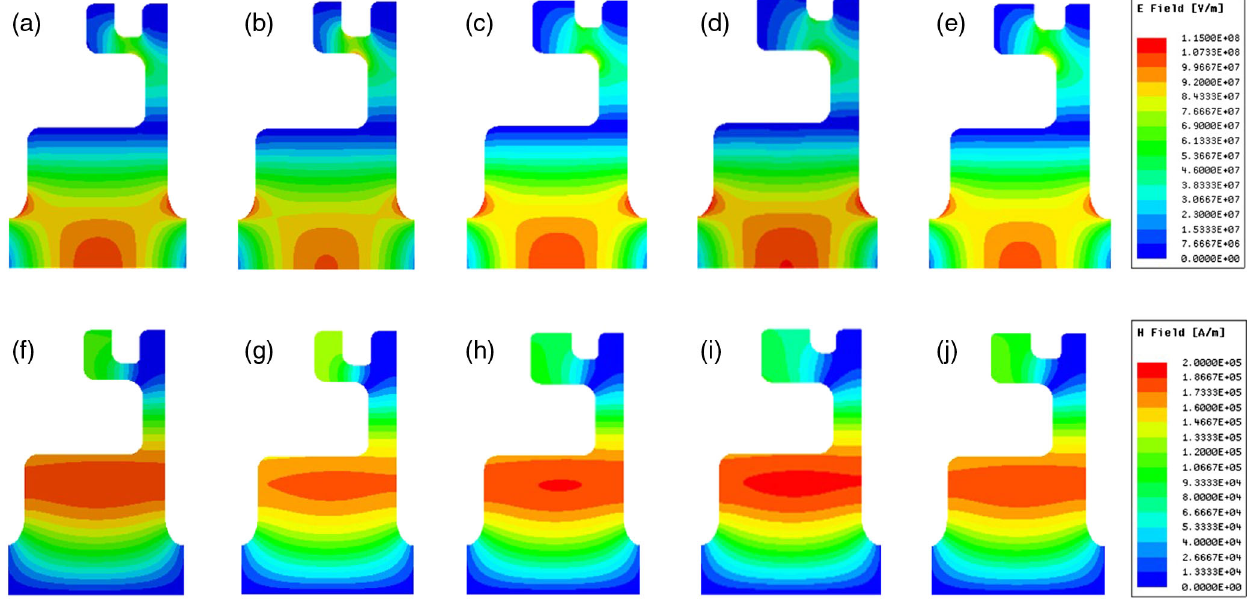
FIG. 5. Electrical and magnetic fields of the middle cells of choke-mode accelerating structures. The loss power of the whole structure is normalized to 1 MW. (a) – (e) are the electrical fields of THU-CHK-#1 to THU-CHK-#5. (f) – (j) are the magnetic fields of THU-CHK- #1 to